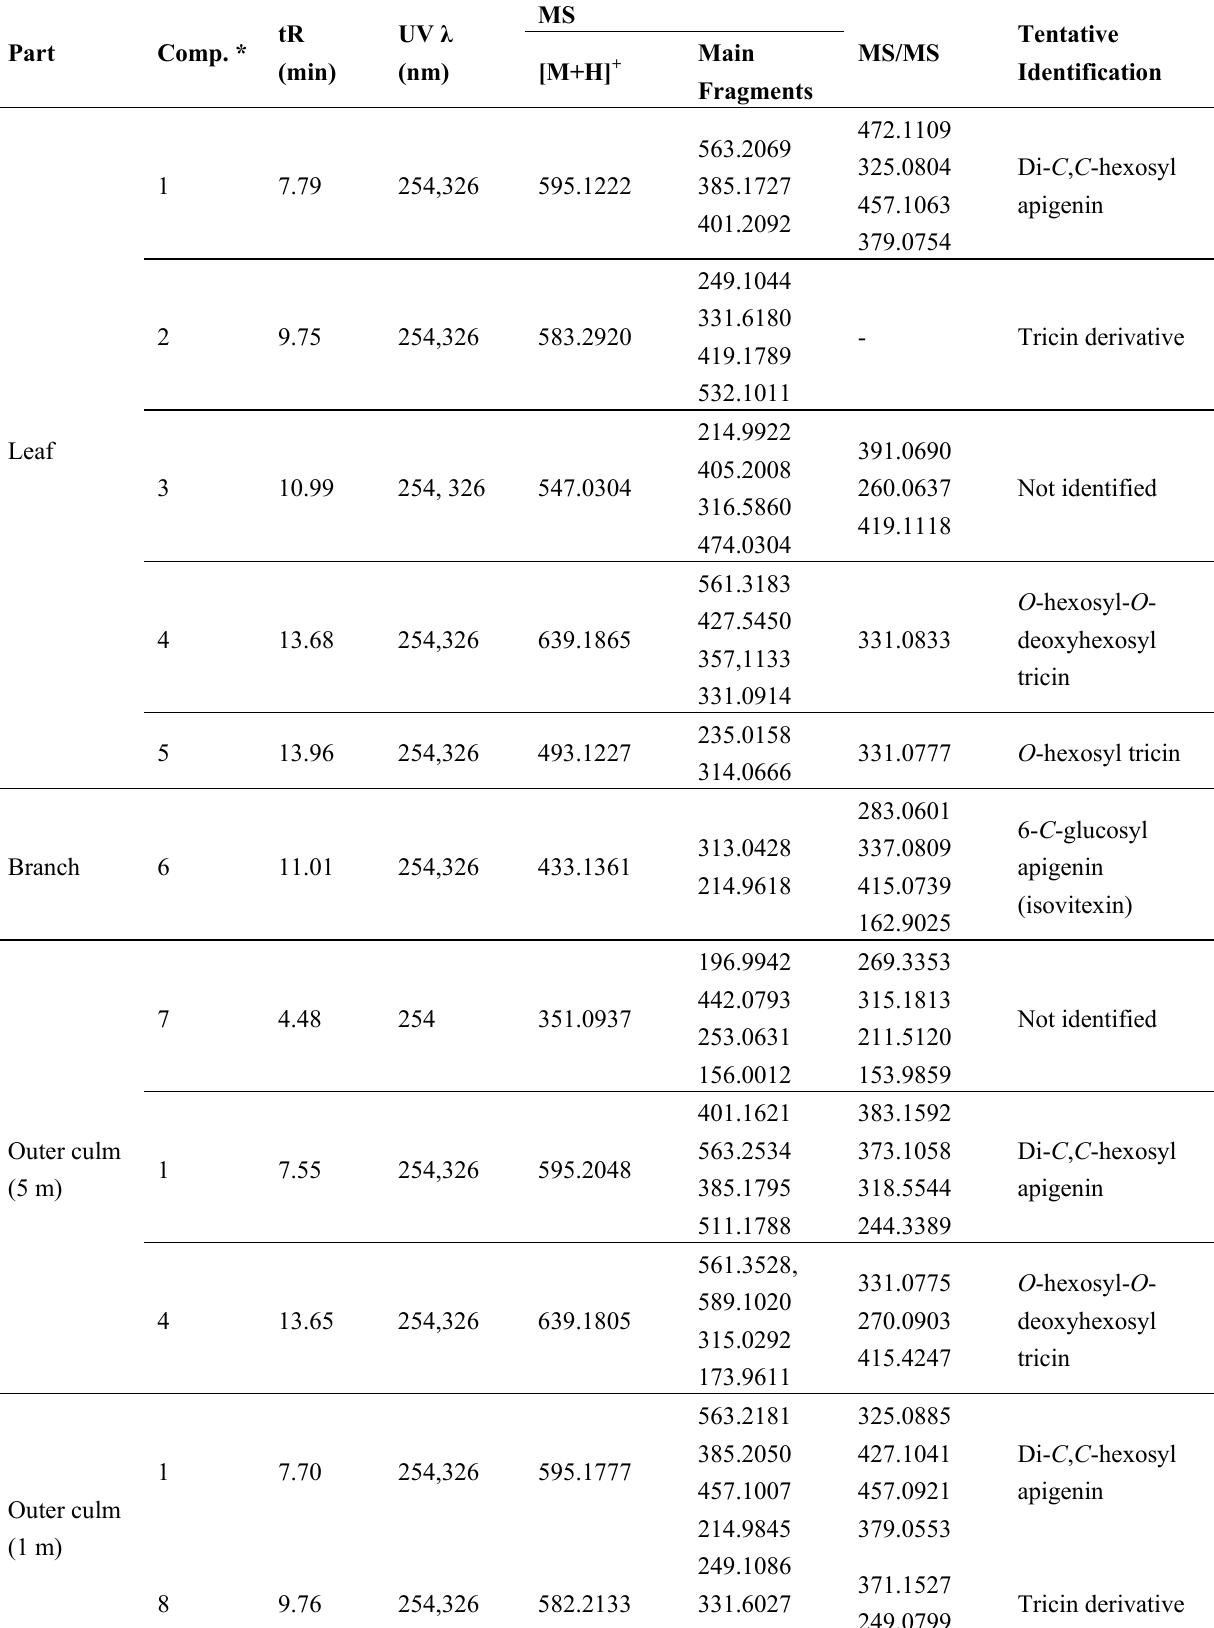
Table 5. Partial characterization of ethanol extracts of various parts of bamboo by LCMS-IT-TOF.